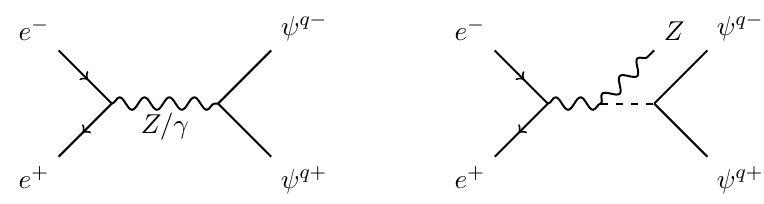
Figure 1 . Example production channels of electroweak multiplets at CLIC. (Left): production through gauge couplings. (Right): production through Higgs portal, allowed for scalar dark matter but typically negligible. See the text for more